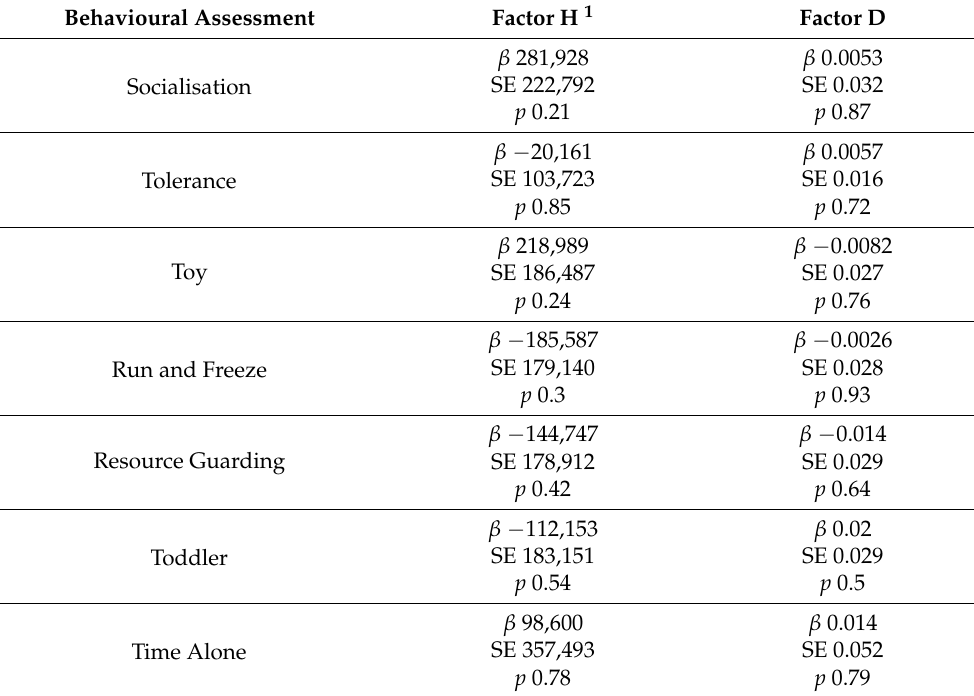
Table 9. Generalised linear mixed model of the effect of canine behavioural assessment on volunteers’ walking experience. Factor H represented human satisfaction factor and factor D represented walker’s perception of dog